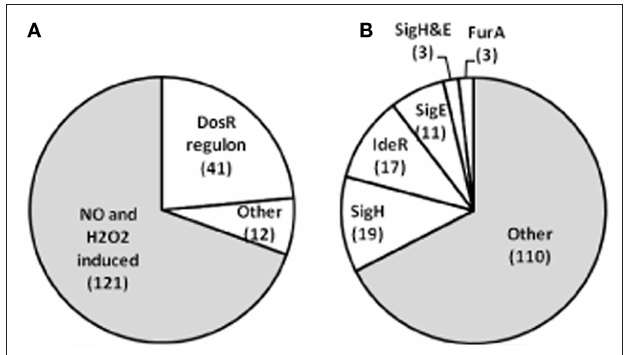
Figure 3 | Distribution of genes regulated in response to NO and H (A) 174 were induced at least 2-fold after 40 min exposure to 0.005, 0.05, 0.5, 1.0, or 5.0 mM DETA/NO and fulfilled the criteria for inclusion in Table A1 . Forty-one of the 174 genes are members of the previously published DosR regulon (Voskuil et al., 2003) and are therefore not included in Table A1 . A majority of genes were regulated by both NO and H 53 genes were regulated solely by NO including the 41 the DosR regulon genes (B) 163 genes from Table A1 were induced by H not induced by NO. Four transcriptional regulators: SigH (Imlay, 2003), IdeR (Rodriguez et al., 2002), SigH (Park and Imlay, 2003), and FurA (this study and Pym et al., 2001; Zahrt et al., 2001) control genes that encompass 33% of the